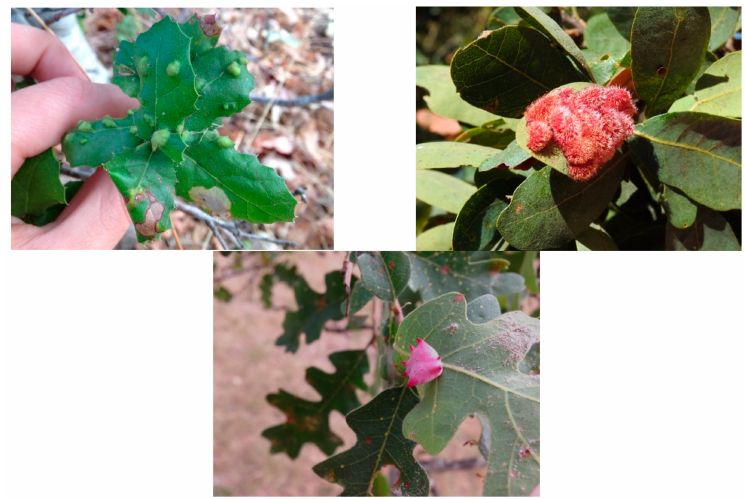
Figure 1. The galling mite Eriophyes mackiei on the host Quercus agrifolia ( top left ). The galling insect Andricus crystallinus on the host Quercus douglasii ( top right ). The galling insect Antron douglasii on the host Quercus lobata ( bottom